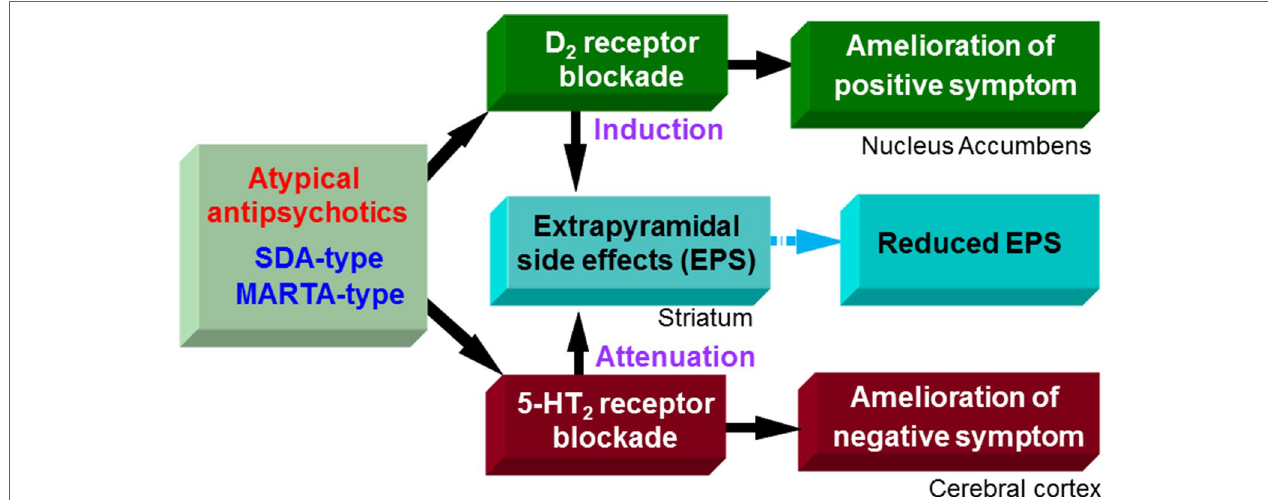
FIGURE 2 | Pharmacological actions of atypical antipsychotics. Likely typical antipsychotic drugs, D 2 blocking actions of serotonin and dopamine antagonists (SDA)- type and multiple-acting receptor targeted antipsychotics (MARTA)-type antipsychotics ameliorate positive symptoms (e.g., hallucination, delusions, and excitation) in schizophrenia, but induce extrapyramidal side effects (EPS). On the other hand, SDA-type and MARTA-type antipsychotics show higher 5-HT 2 than D 2 binding affinities and possess potent